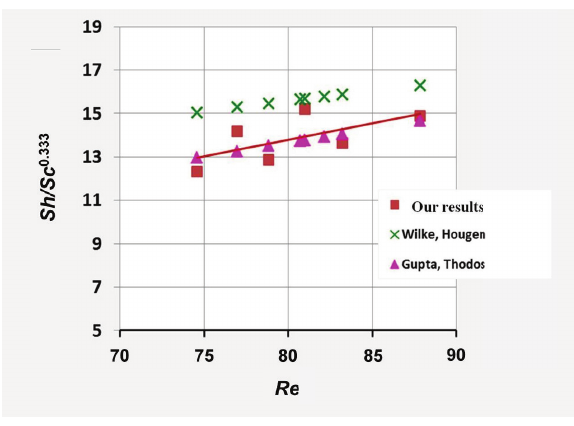
Fig. 11 - Comparison of our results with the experimental results of other authors 17,19,20 Pavel Hoffman: Effect of fluidized bed stirring on drying process of adhesive particles